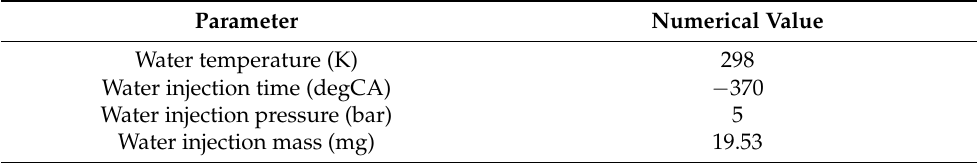
Table 9. Water injection parameters.